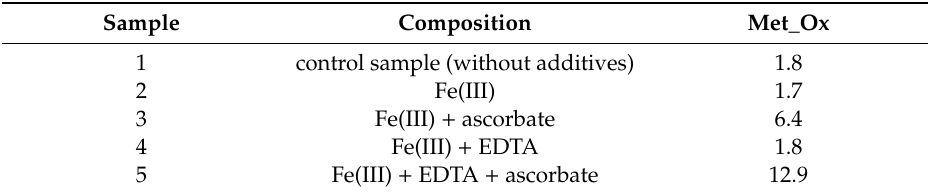
Figure 5. HPLC-UV peptide map of the degraded and non-degraded protein considering the oxidised methionine peaks indicated (Met_ox). The five experimental conditions (‘sample names’) are as indicated in Table 1. Table 1. Peptide mapping analysis for the methionine oxidation, as determined by HPLC-UV (e.g., Figure 5).